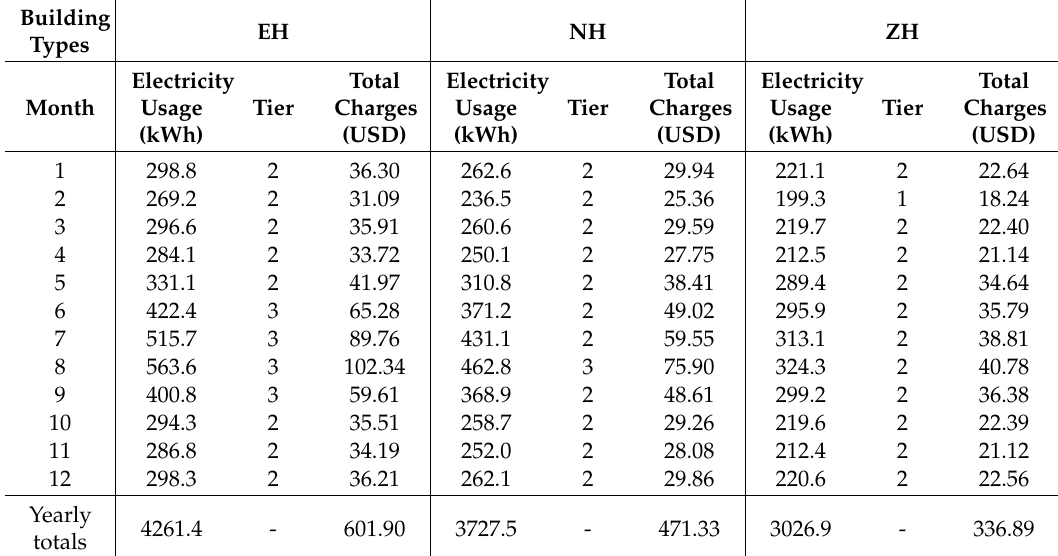
Table 13. Monthly electricity charges.